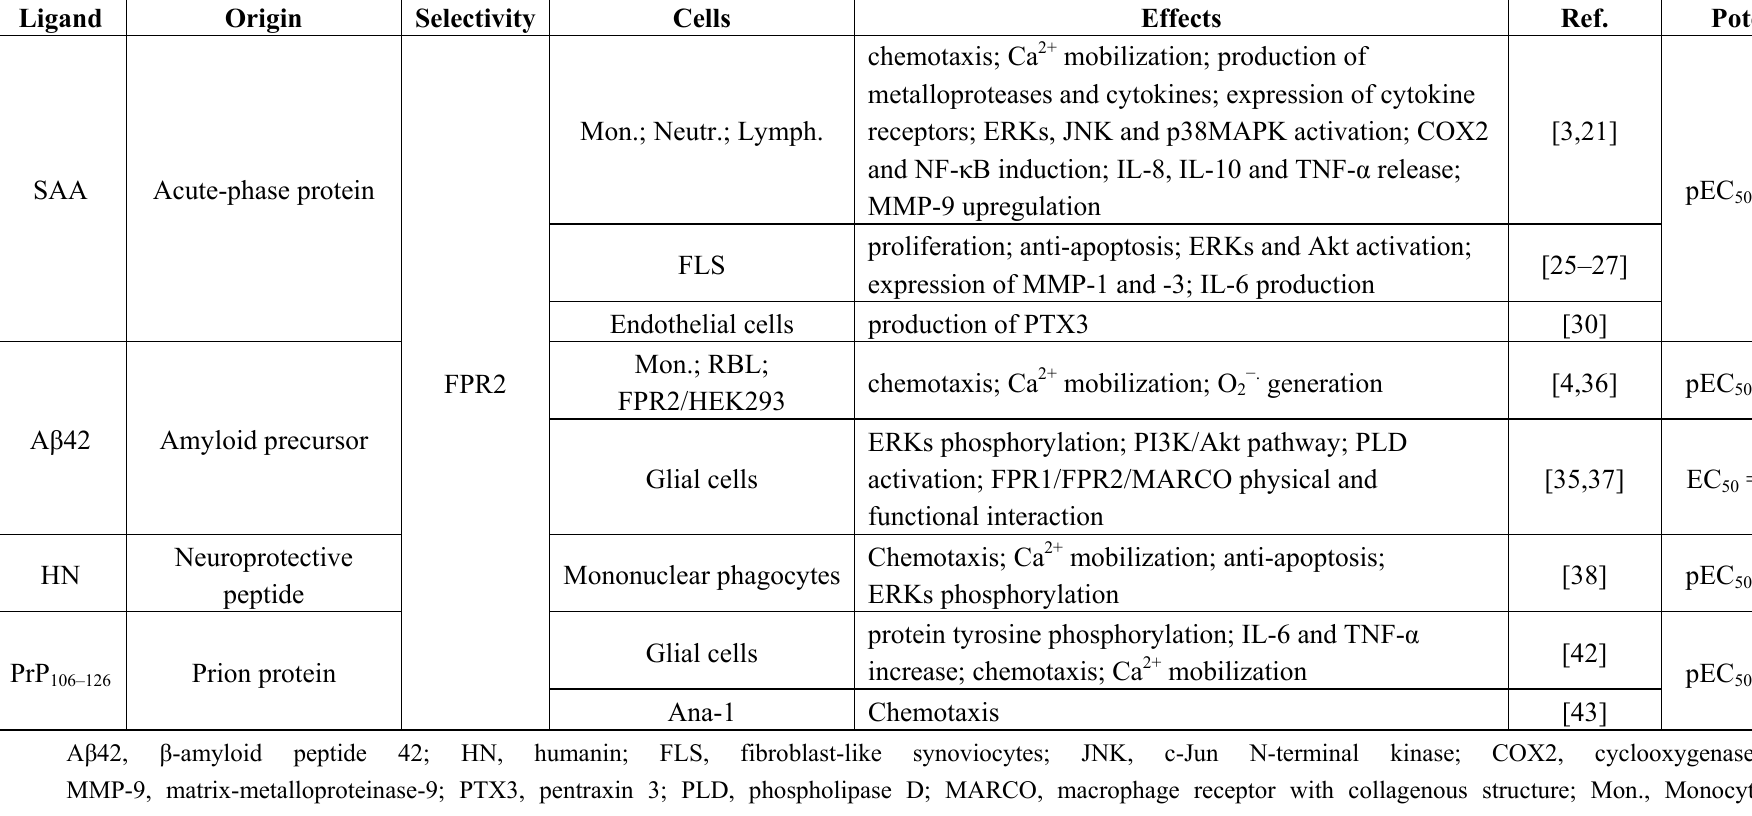
Table 3. Intracellular signaling cascades triggered by amyloidogenic peptides and